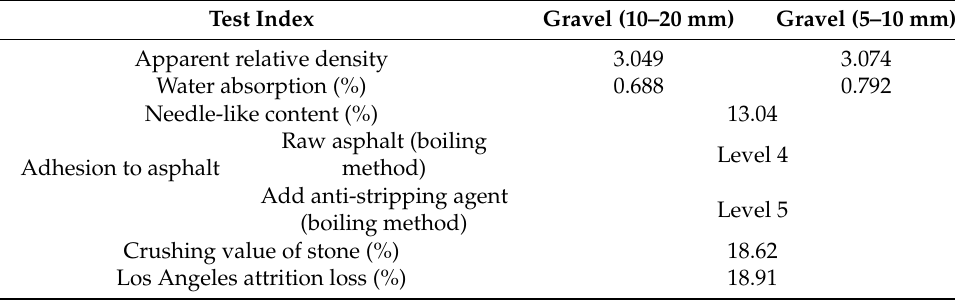
Table 2. Test results of coarse